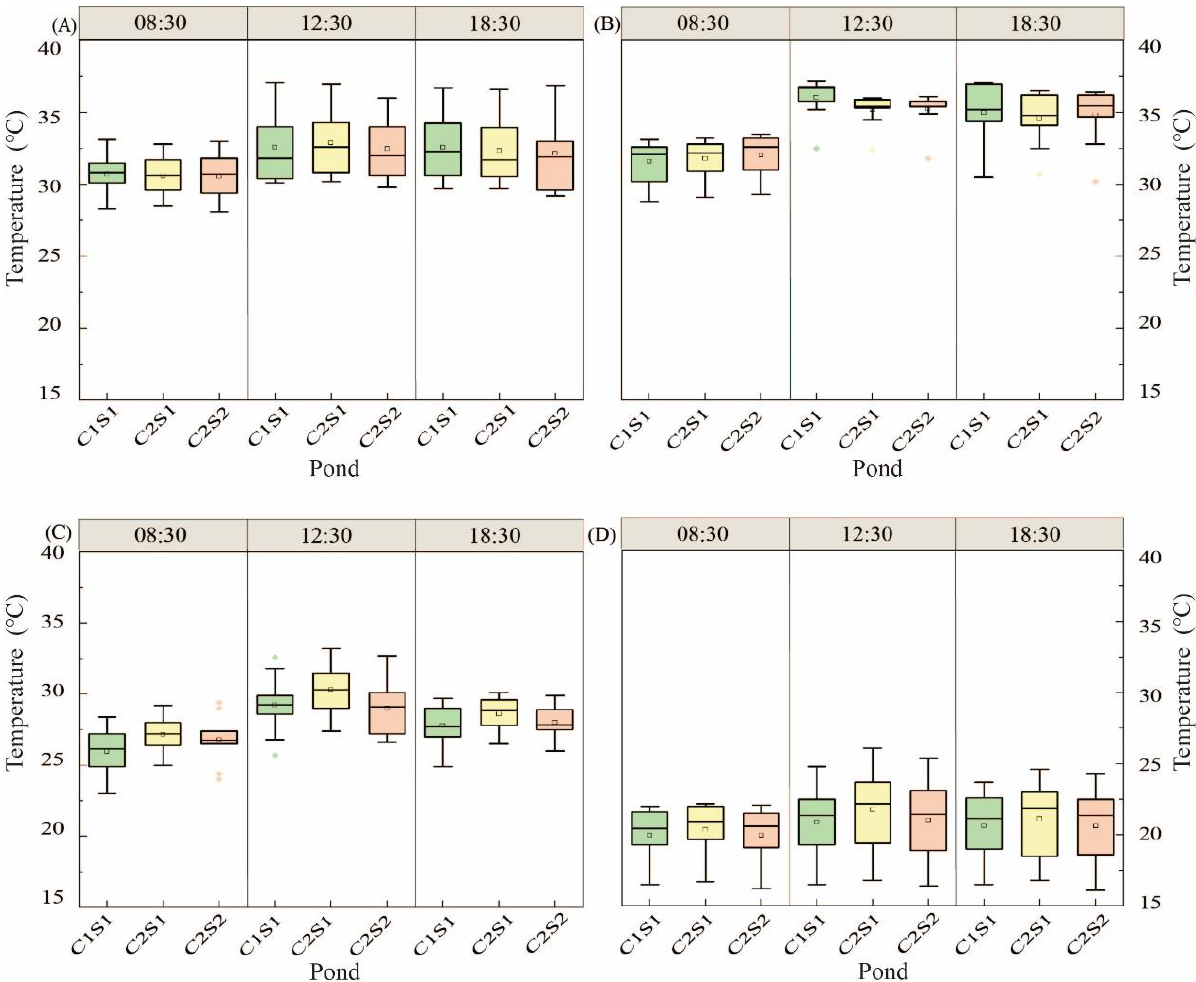
Figure 2. Monthly variation of water temperature in different ponds. ( A ) July; ( B ) August; ( C ) September; ( D ) October.